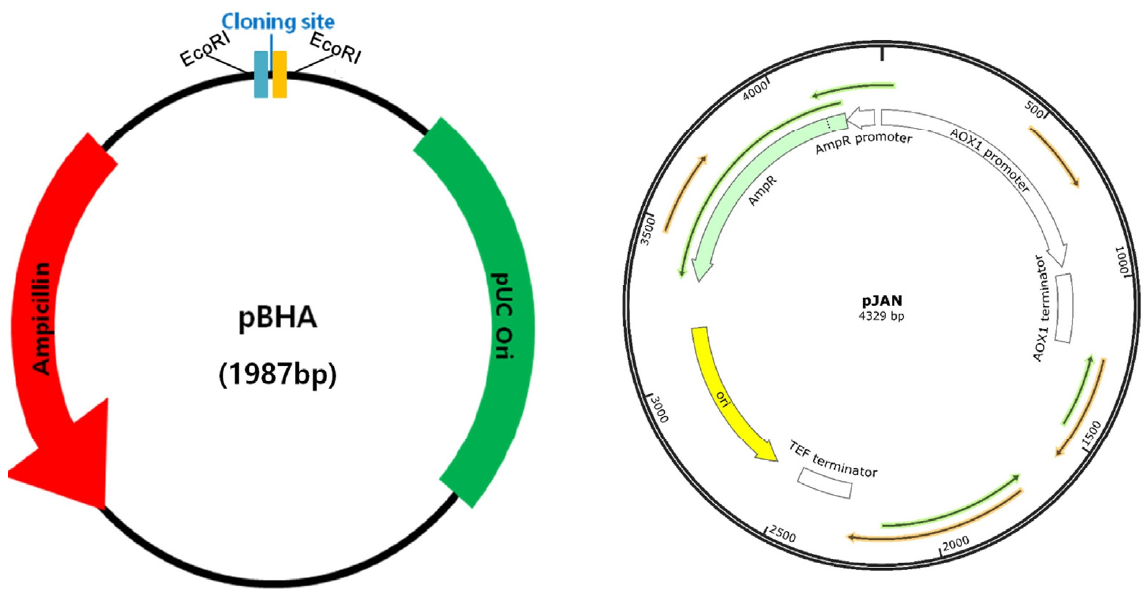
Figure 4. Plasmid (BHA) & Plasmid JAN (Bioneer Co, Daejeon, Republic of Korea).